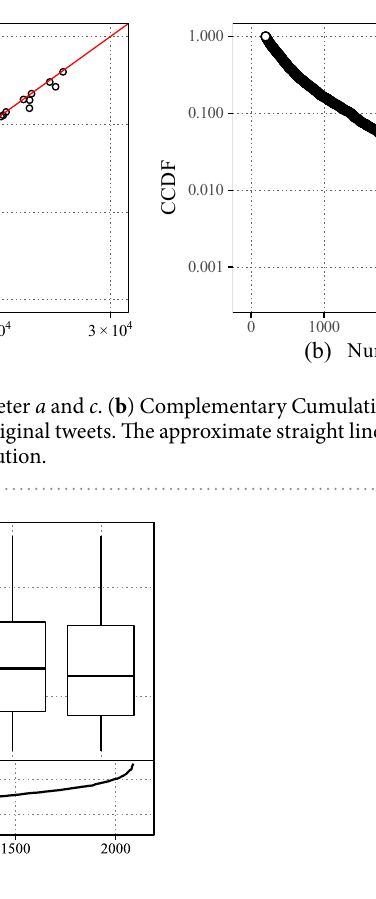
Figure 9. The variation of the relaxation exponent b and the distribution of the parameter λ of the exponential model fitted to groups of r act